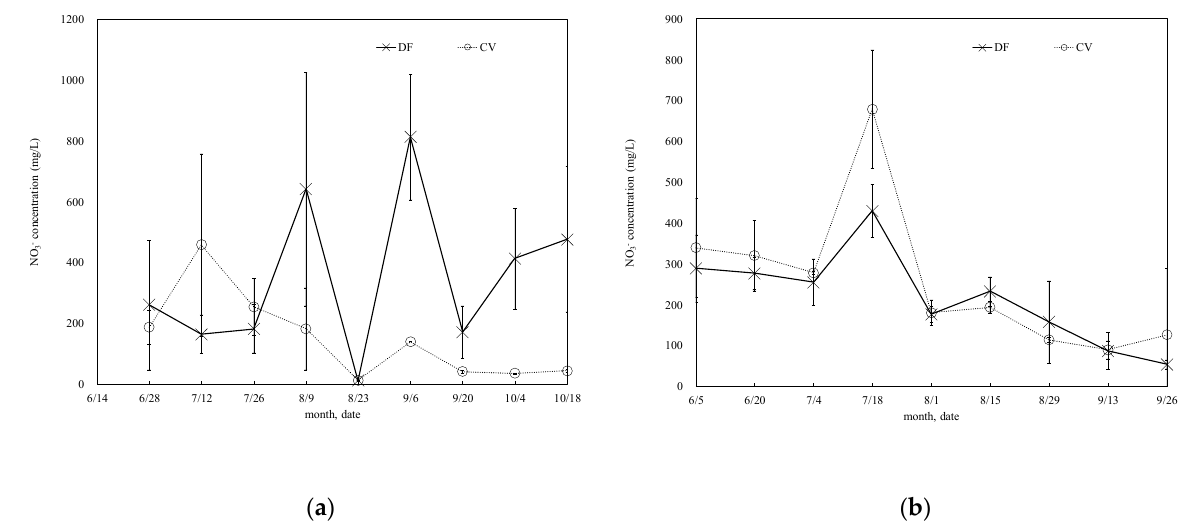
Figure 5. Chronological changes of nitrate ion concentration in the soil determined using the Dutch 1:2 soil–water extract method. ( a ) 2016. ( b ) 2017. DF, drip fertigation; CV, conventional fertilization. Vertical bars indicate standard error ( n = 3–5).